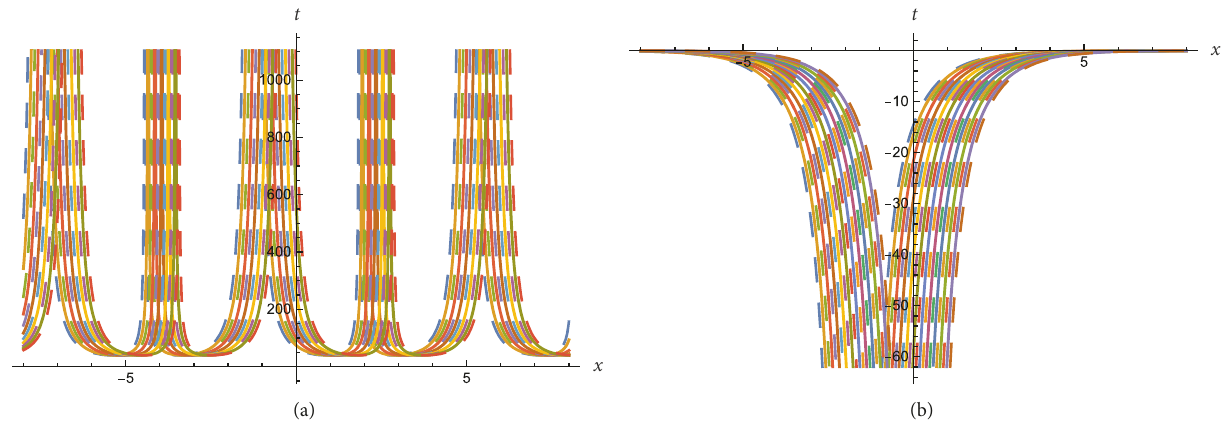
Figure 7: Plot of the exact traveling wave solutions of (a) periodic solitary wave solution (39) with parameters 𝑎 1 = 9;𝛼 = 0.6; 𝑙 2 = −1; 𝑙 3 = −1;𝜅 = 0.7;𝑐 = 0.1;𝑦 = 0.8 ; (b) dark solitary wave solution (41) plotted at 𝑎